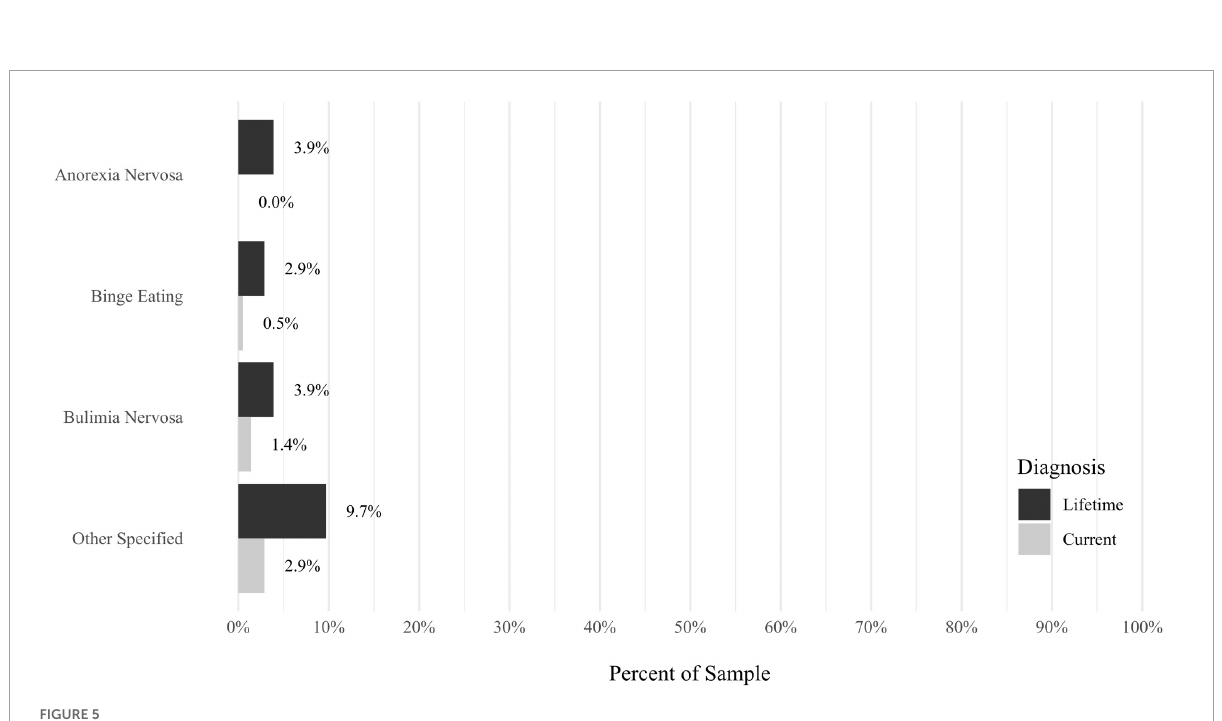
FIGURE5 Rates of psychiatric disorders: eating